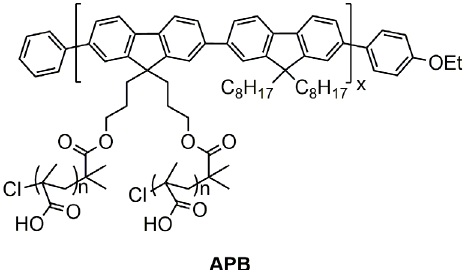
Figure 1. Structure of amphiphilic polymer brushes with a polyfluorene backbone and polymethacrylic acid side chains.